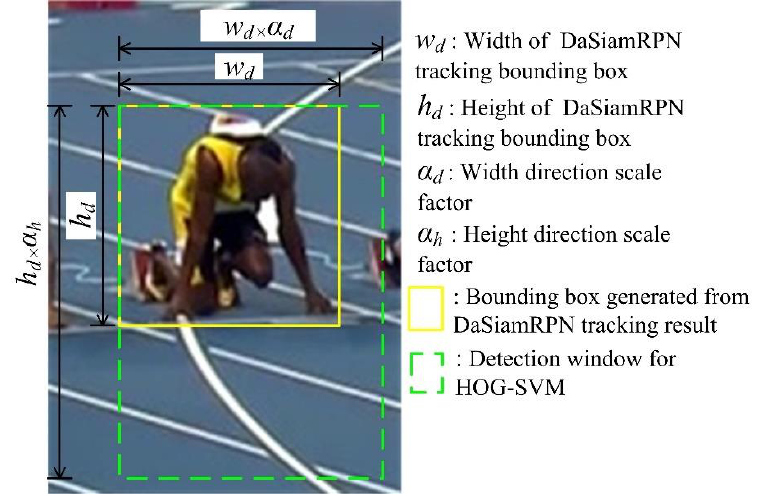
Figure 4. New detection window based on the DaSiamRPN tracker.